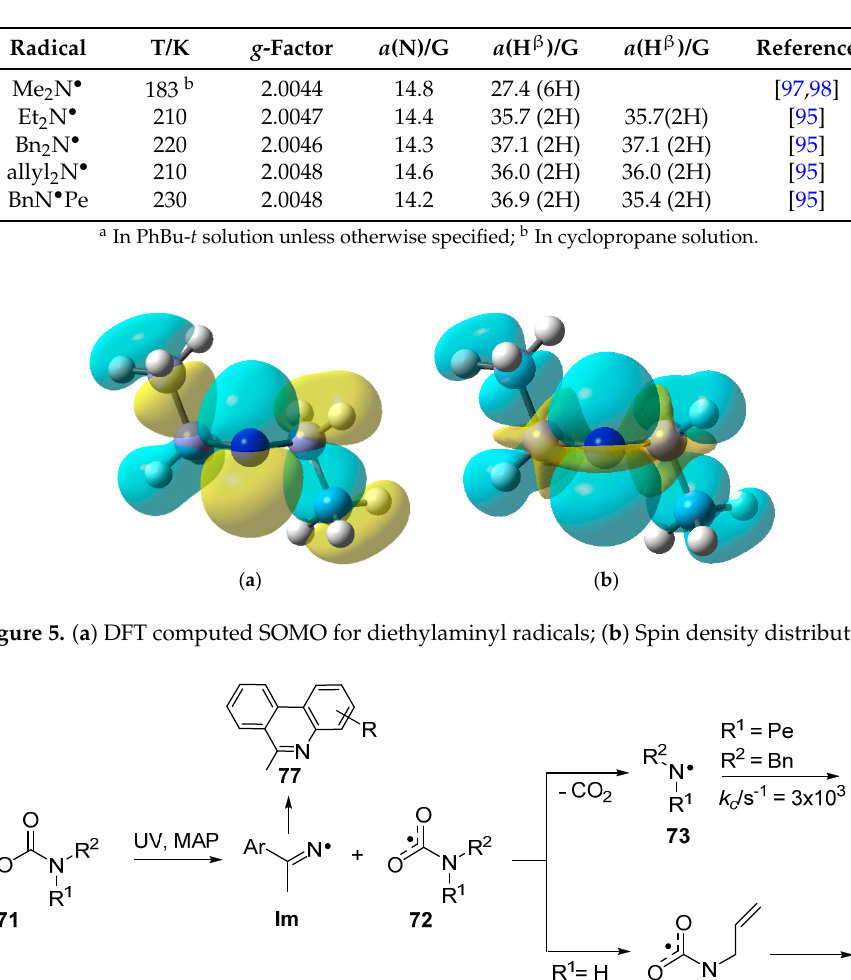
Table 4. Isotropic EPR parameters for selected dialkylaminyl radicals R 2 N • a .